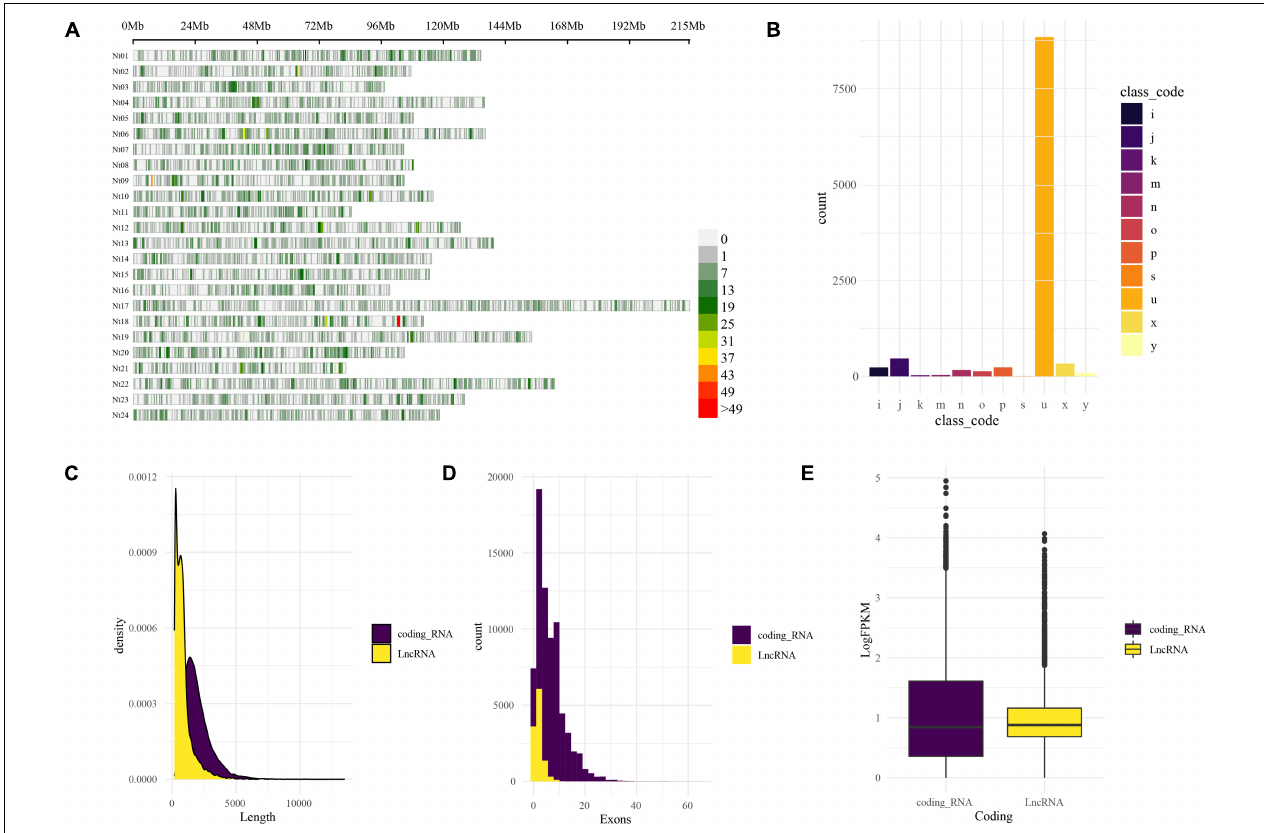
FIGURE 2 | Genome-wide identification and characterization of LncRNA in tobacco under low K. (A) LncRNA distribution on the tobacco reference genome. The LncRNA distribution and density are demonstrated by the chromosomes’ physical positions and coloration; the window size is 1-Mb base pairs. (B) Physical position compared with reference annotation. The transcripts were classified by GffCompare software into different groups in different colors and marked with characters and symbols. For example, “u,” intergenic; “i,” fully contained within intron; “j,” multi-exon with at least one junction match; “o,” other same strand overlap with reference exons; “p,” possible polymerase run-on; “x,” exonic overlap on the opposite strand; “s,” intron match on the opposite strand; “k,” containment of reference; “m,” retained intron, all introns matched; “n,” retained intron, not all introns matched; “y,” contains a reference within its intron; (C) length distribution of coding RNAs and LncRNAs. (D) Exons distribution of coding RNAs and LncRNAs. (E) The expression abundance (logFPKM) of coding RNAs and